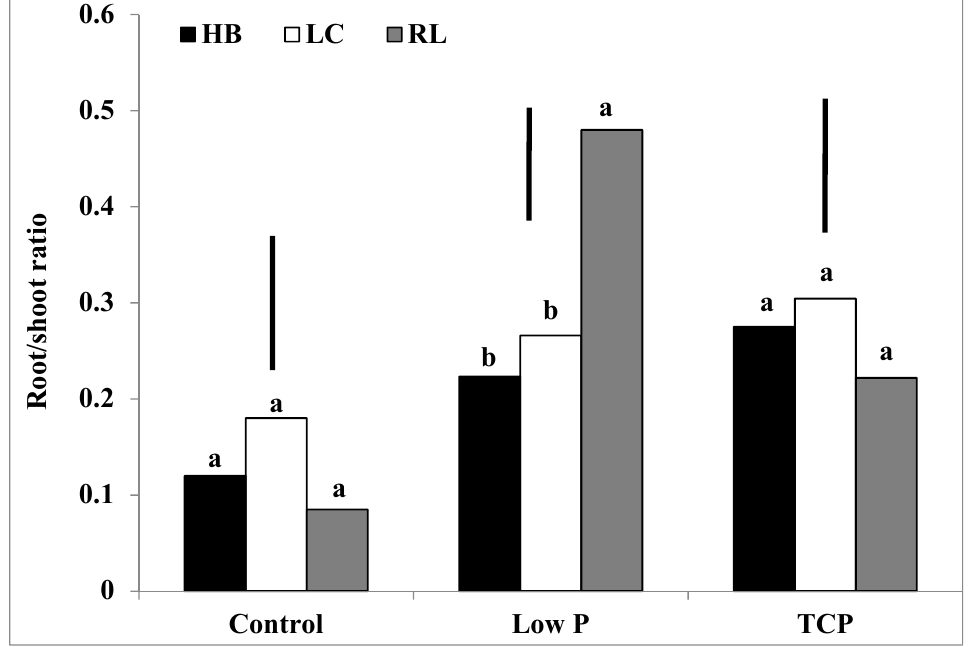
Figure 4. Root–shoot ratio of potato seedlings grown in modified Hoagland solution with different P bioavailabilities for 28 days. Histograms with different letters in the same treatment are different at p < 0.05. Control: 10 mg L − 1 P as water soluble P, NaH 2 PO 4 ; Low P: 1 mg L − 1 P as water soluble P, NaH 2 PO 4 ; and 286 mg L − 1 TCP, tri-calcium phosphate, Ca 3 (PO 4 ) 2 as sparsely soluble P and 2,286 mg L − 1 laboratory grade Ca 3 (PO 4 ) 2 . HB: ‘Harley Blackwell’; LC: ‘La Chipper’; RL: ‘Red LaSoda’. The bars are the values of LSD 0.05, 2 for the plant biomass of the control, low P and TCP, respectively.